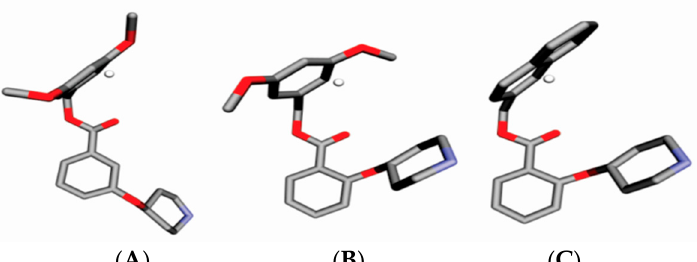
Figure 8. Representation of GCOD-6 ( − 1, − 4, − 3, any) (white sphere) and ( A ) compound 14 , ( B ) compound 19 , and ( C ) compound 22 . CODs occupancy represented by white spheres contributes to increasing the potency of compounds, and the gray and red representations are carbons and oxygen atoms.